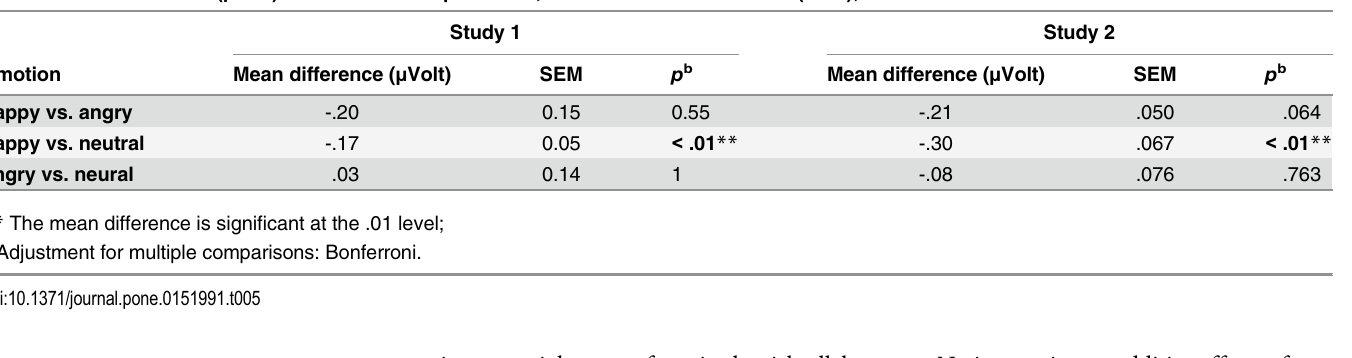
Table 5. Mean difference ( μ Volt) between facial expressions, standard error of the mean (SEM);